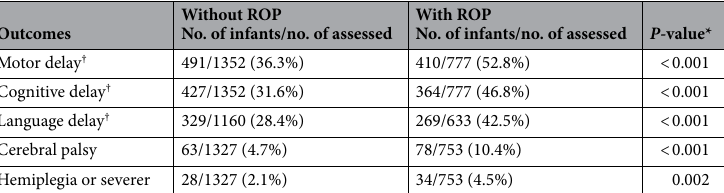
Without ROP No. of infants/no. of assessed